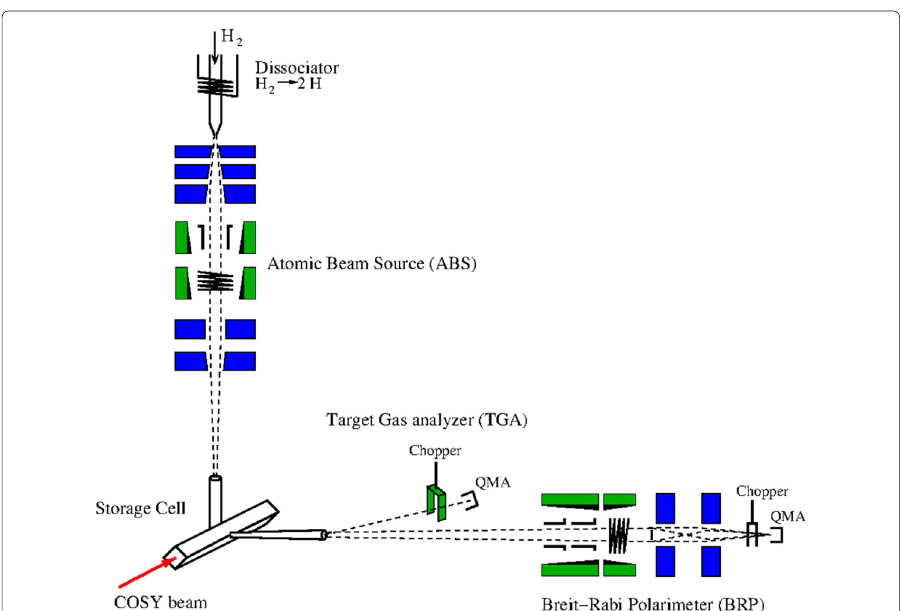
Fig. 7 Schematic drawing of the PAX polarized target with the ABS in the vertical position, the storage cell on the ring axis, and the target diagnostic system in the horizontal position. The Target Gas Analyzer (TGA) determines the atomic to molecular fraction of the effusive beam from the storage cell, while the Breit–Rabi Polarimeter (BRP) measures the degree of polarization of the atomic